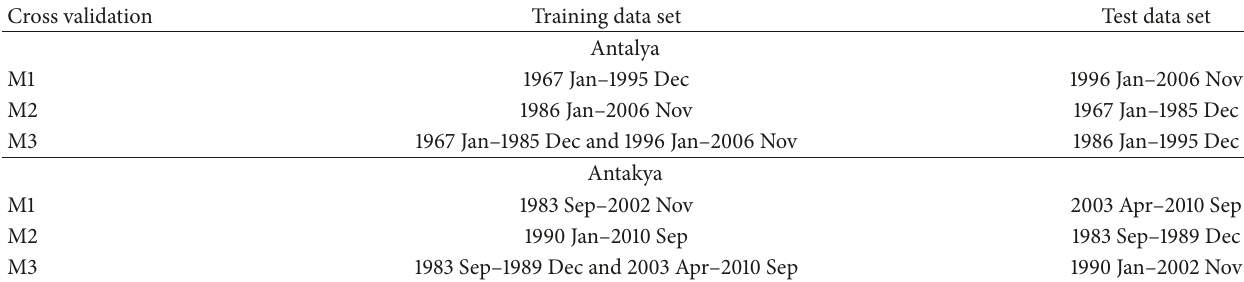
Table 2: The training and test data sets used for each model.